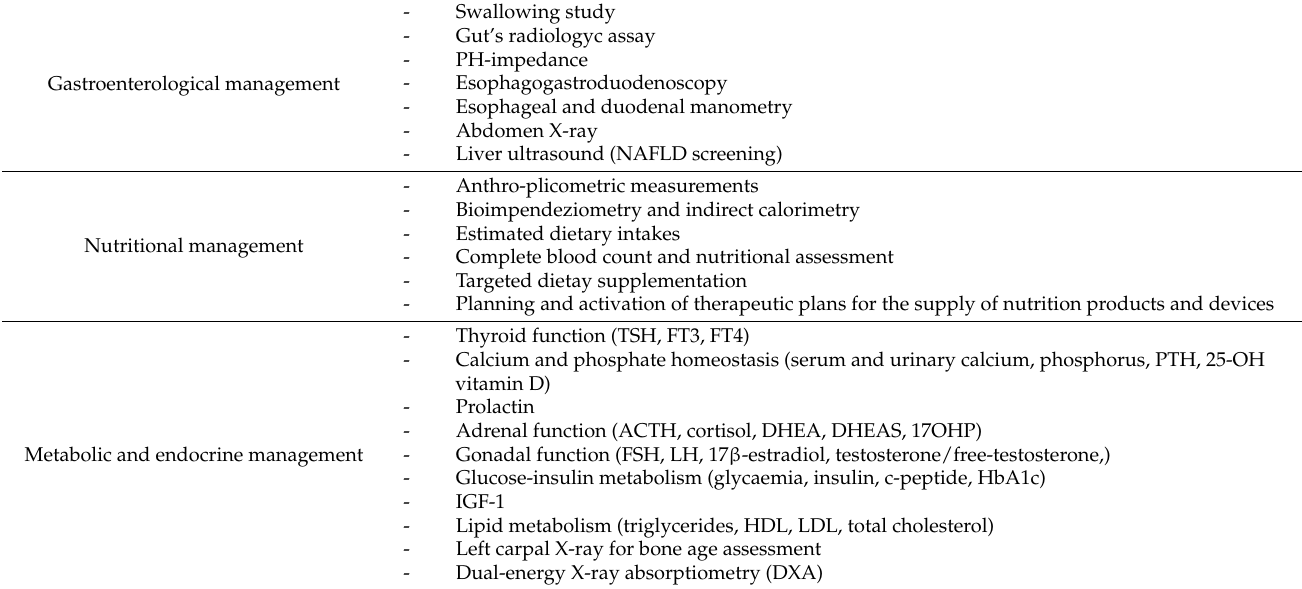
Table 1. A proposed multidisciplinary approach in the management of patients with SMA1.